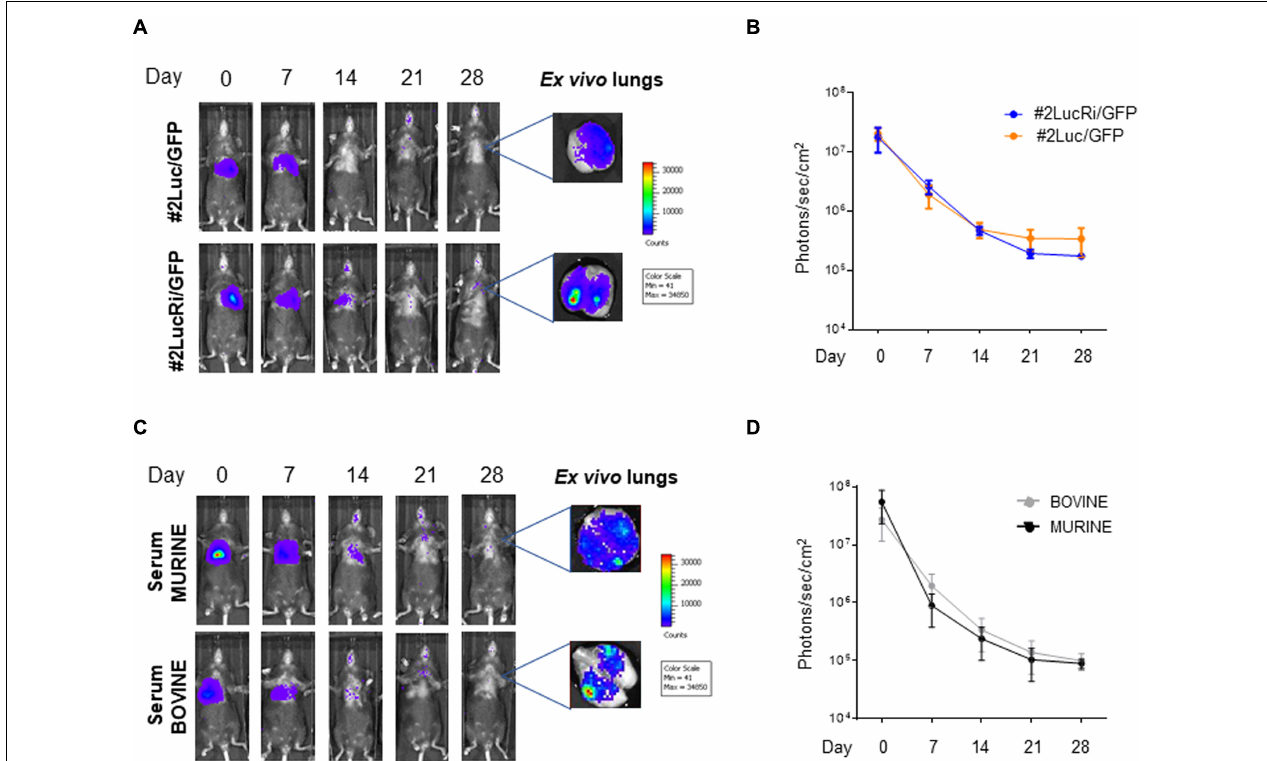
FIGURE 3 | In vivo and ex vivo imaging of intratracheally (IT) injected mouse bone marrow-derived mesenchymal stromal/stem cells (mBM-MSCs). (A) In vivo bioluminescence imaging (BLI) of four groups of mice ( n = 5 each) IT inoculated with mBM-MSC clone #2Luc/GFP or clone #2LucRi/GFP. Mice were weekly monitored up to 4 weeks post inoculation. At each time point, mice were longitudinally detected for in vivo BLI. On day 28, mice were anesthetized and lungs were harvested for ex vivo imaging using In Vivo Imaging System (IVIS) BLI system. No significant differences in survival were detected between mice transplanted with clone #2LucRi/GFP and mice transplanted with parental clone #2Luc/GFP ( p > 0.05, two-way ANOVA test followed by Sidak’s test for multiple comparisons). (B) BLI signal from mouse chest of each group was quantified six times, expressed as photons/s/cm 2 and plotted as mean ± standard error of the mean (SEM) using the software Living Image R (cid:13) version 4.3.1. BLI signal at each time point represents the mean ± standard deviation of five animals. (C) In vivo longitudinal BLI quantification comparison between IT inoculated mice with clone #2LucRi/GFP differentially cultured with murine or bovine serum. (D) BLI signal from mouse